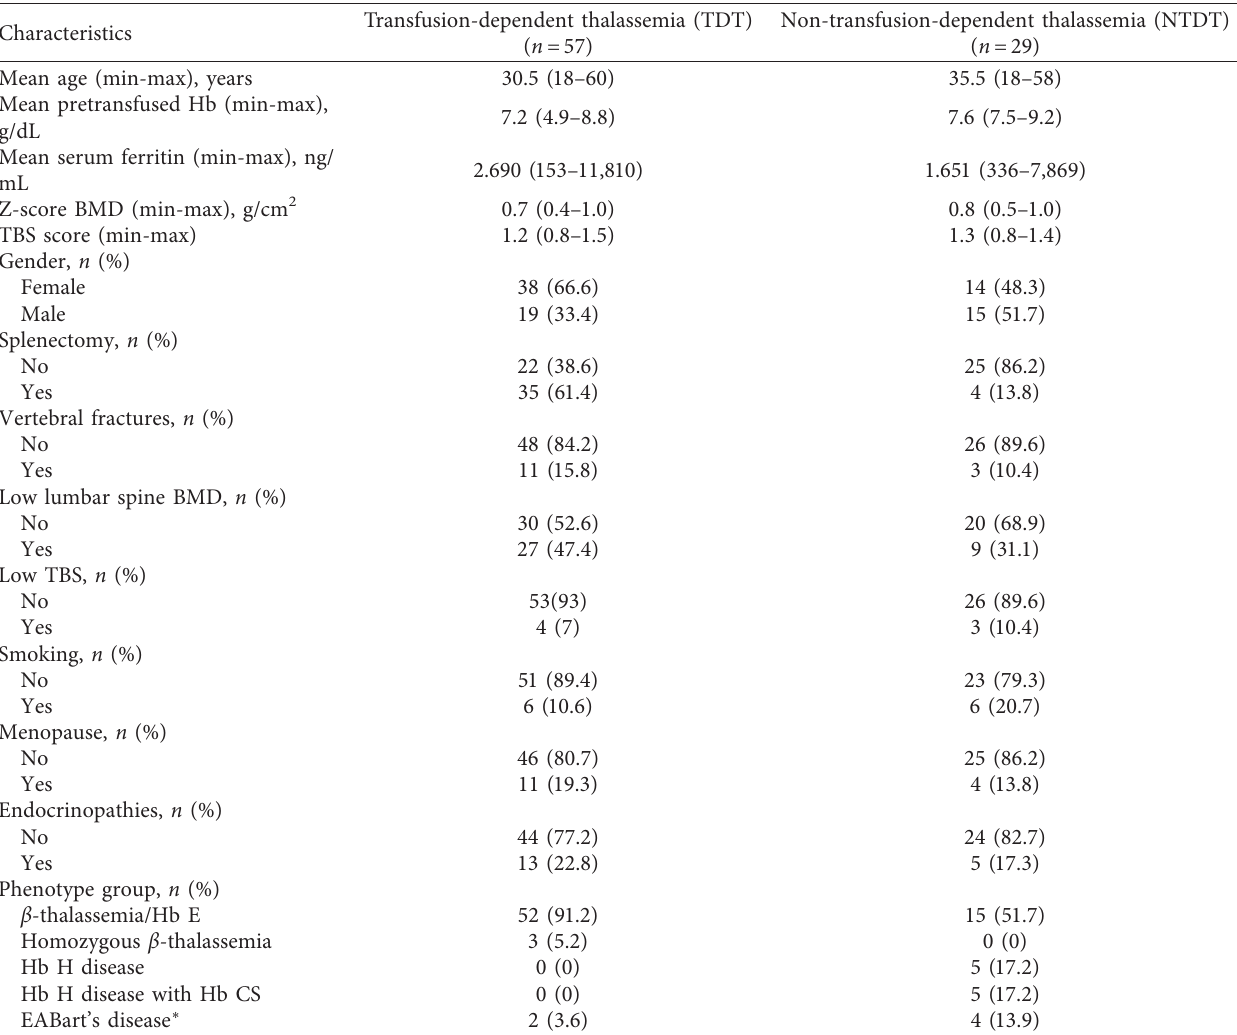
Table 1: Baseline characteristics of 86 patients with thalassemia.